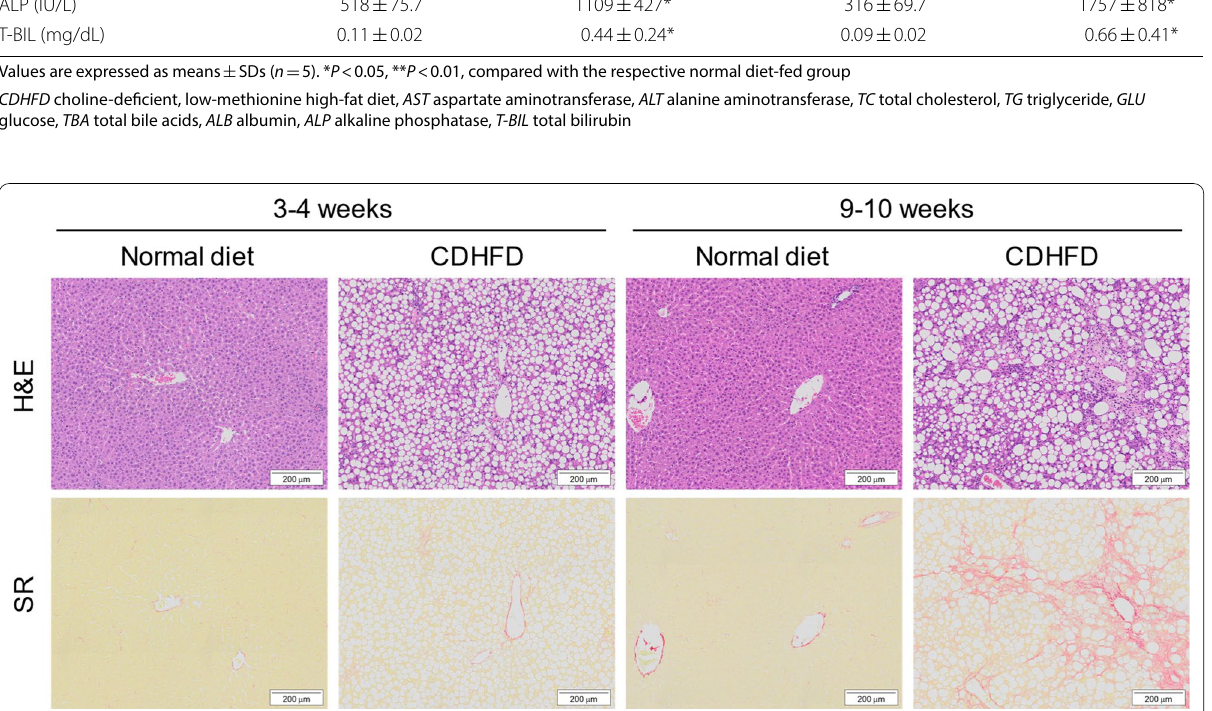
Fig. 2 Representative photomicrographs of hepatic histopathology in H&E- and Sirius red-stained sections. CDHFD choline-deficient, low-methionine high-fat